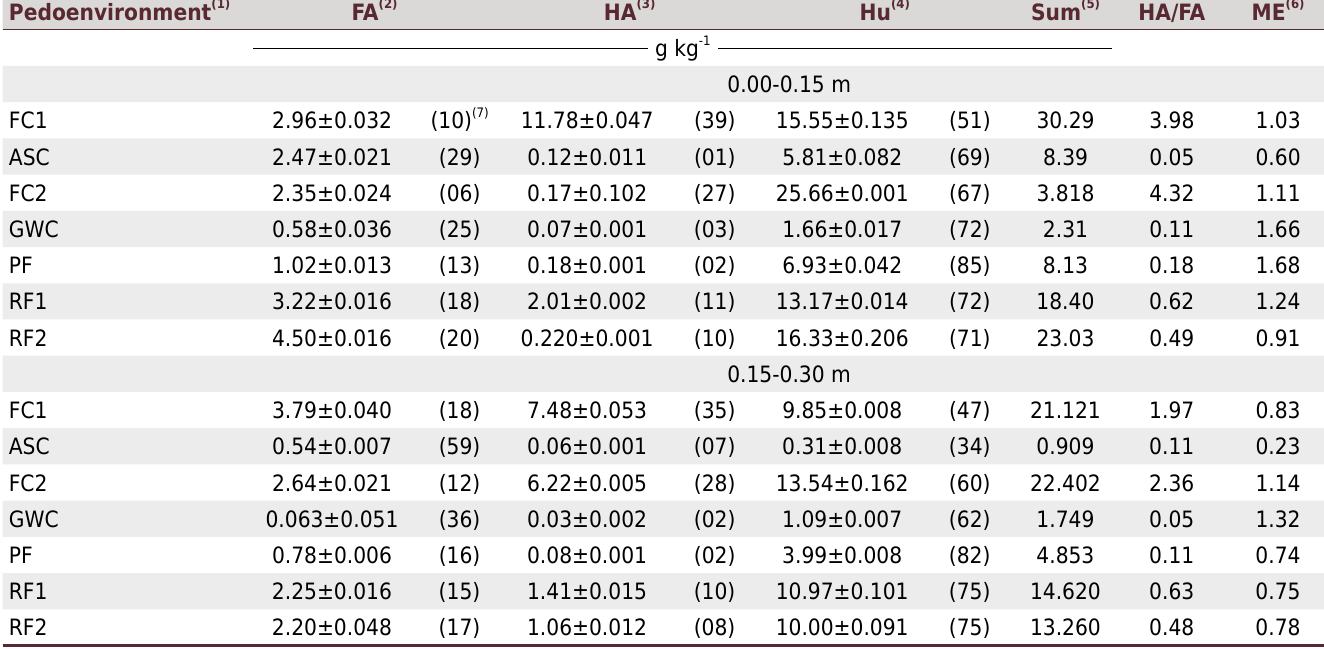
Table 4. Carbon content of fulvic acid (FA), humic acid (HA), and humin (Hu), HA/FA ratio, and method efficiency in soils from the pedoenvironments studied at two soil depths in the Viruá National Park, Roraima,